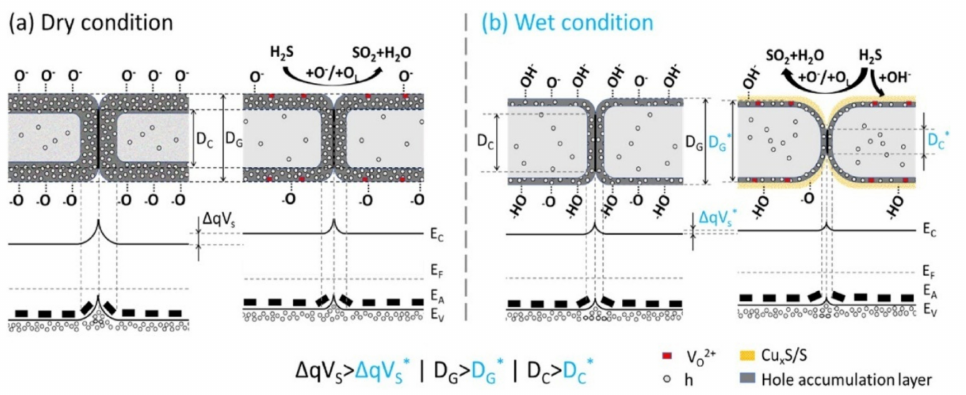
Figure 2. Schematic of H 2 S detecting mechanism of p-CuO nanosheet gas sensor in ( a ) dry and ( b ) humid environments. Reprinted from [39] with permission from